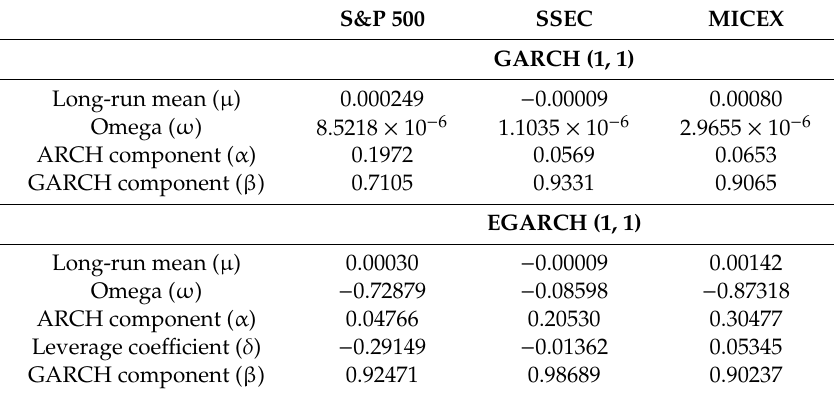
Table 5. Estimates of the Parameters of GARCH (1,1) and EGARCH (1,1) (with